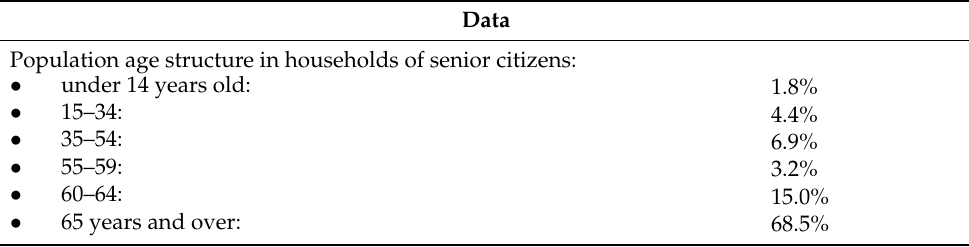
Table 5. Demographic profile of a Polish senior. Source: own elaboration on the basis of [90–101].